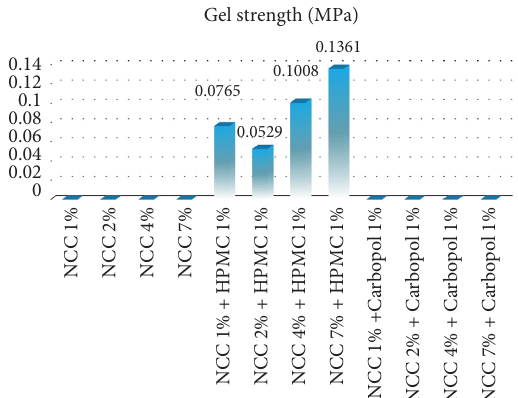
Figure 5: The gel strength (MPa) values for 1%, 2%, 4%, and 7% NCC with hydroxypropyl methylcellulose (HPMC) and carbopol